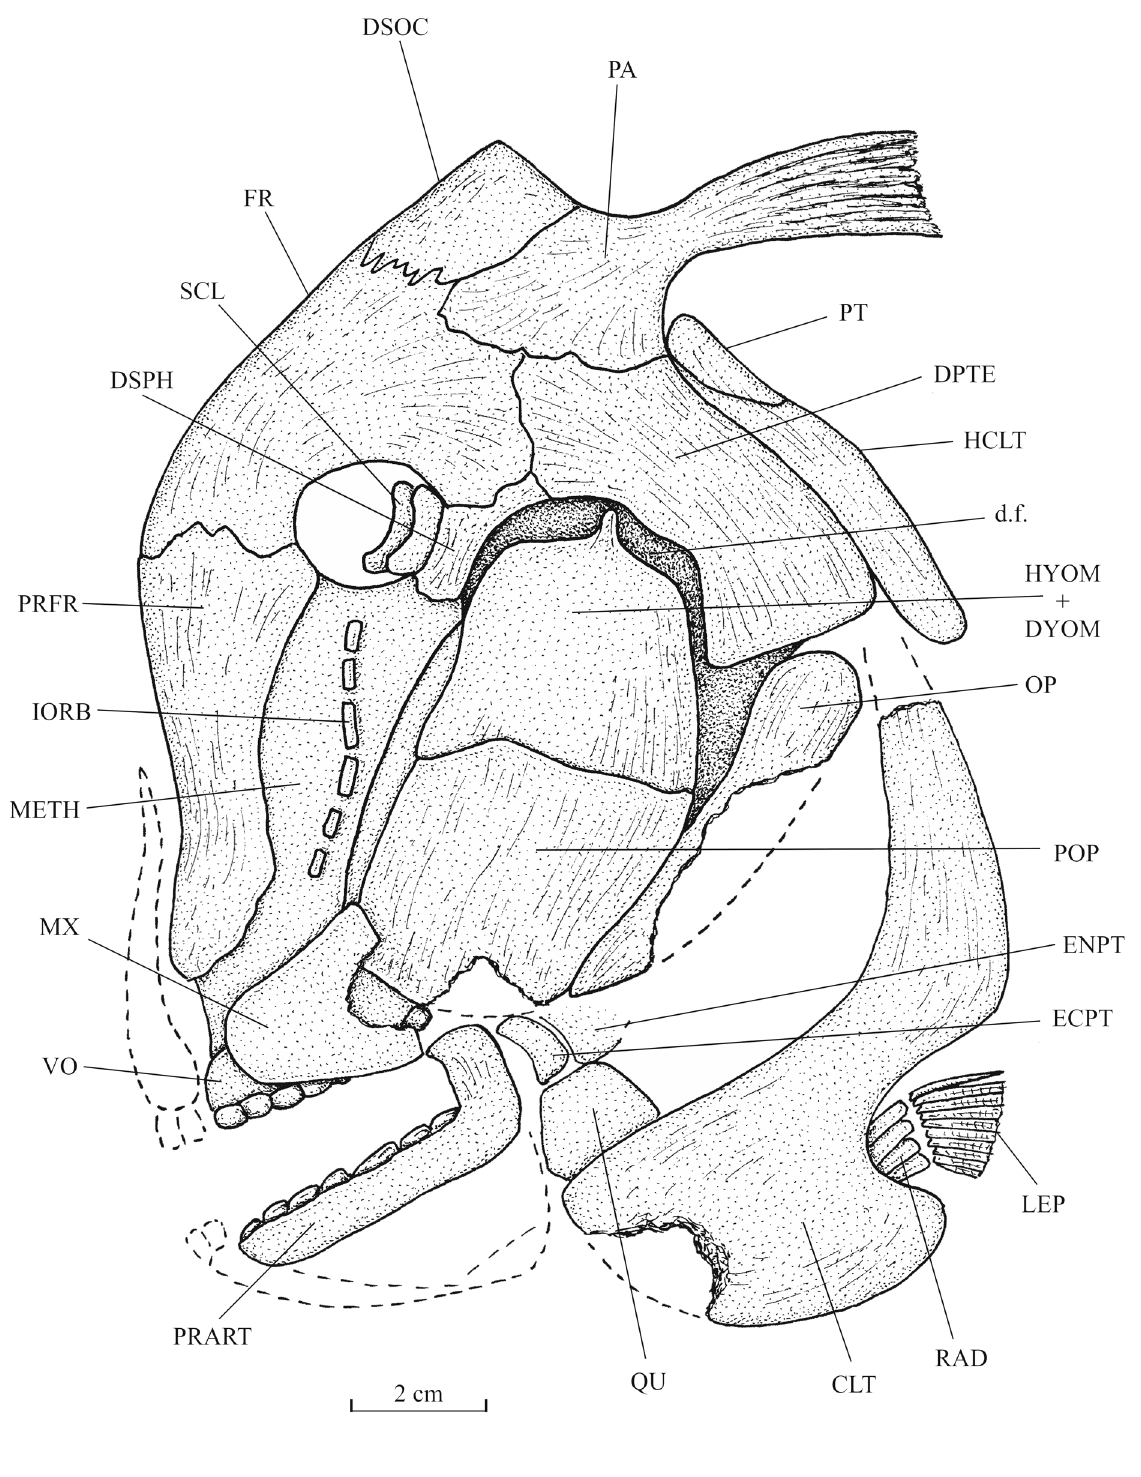
Fig. 17. Sigmapycnodus giganteus gen. et sp. nov., holotype, skull and pectoral girdle (CLC S-497a,